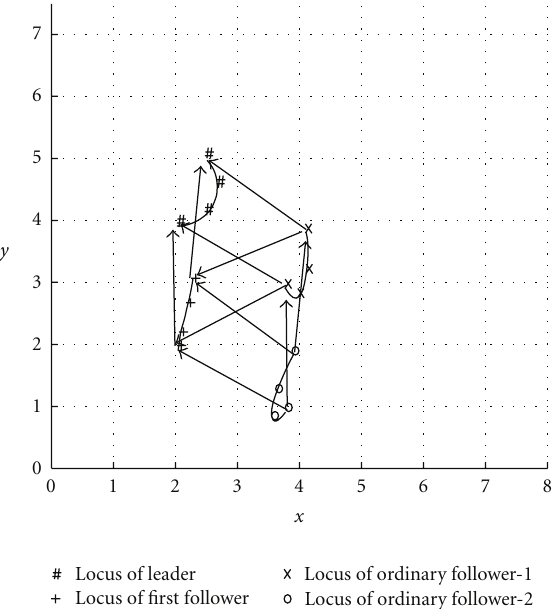
Figure 6: Motion of formation of four agents with leader- follower structure, with 0.09 degree (approximately 0.00157 radian) orientation at each instant of time provided in the motion of leader.